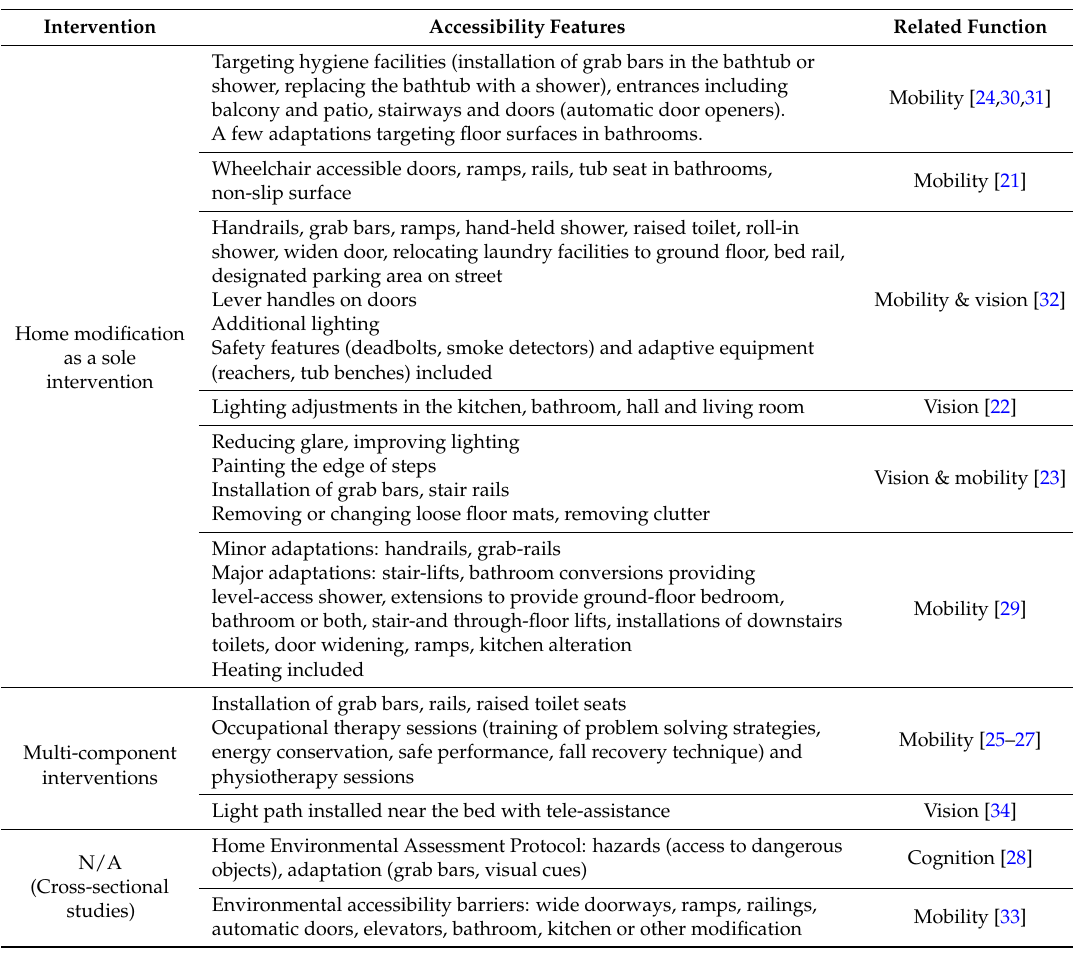
Table 3. Descriptions of accessibility features in each study